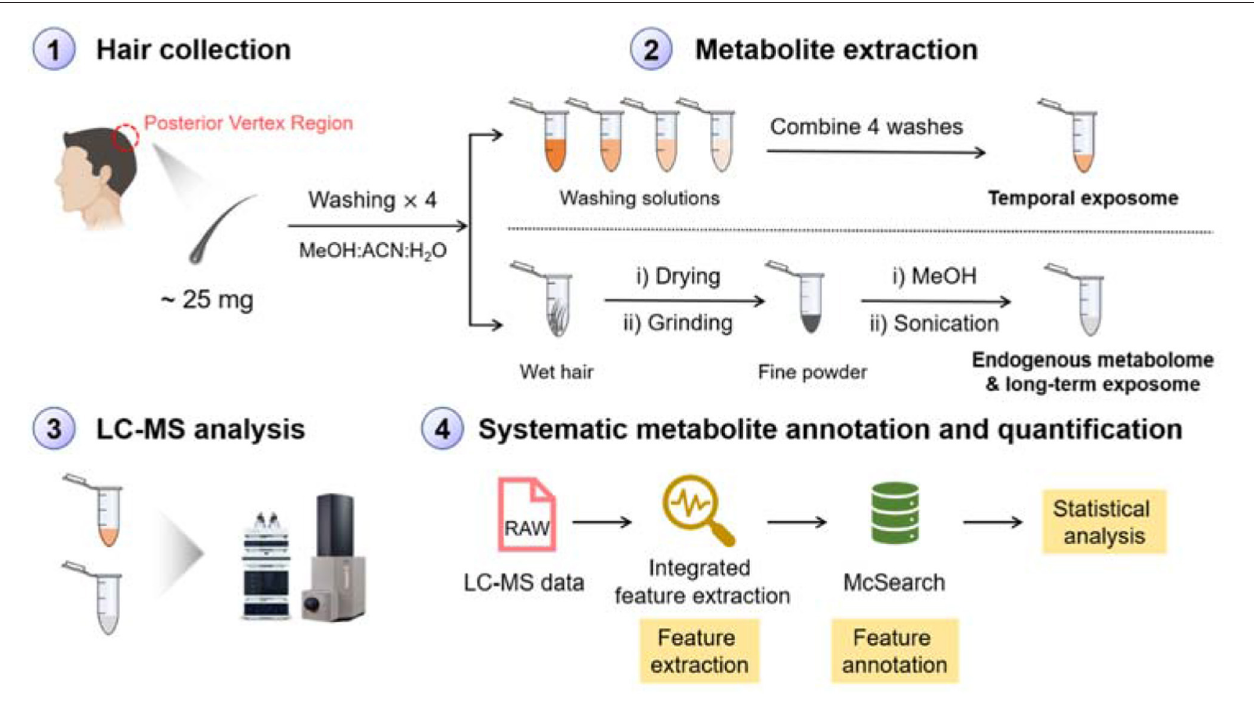
FIGURE 1 | Schematic workflow of hair sample preparation, LC-MS analysis, data processing, and metabolite annotation for simultaneous profiling of endogenous metabolites, temporal, and long-term